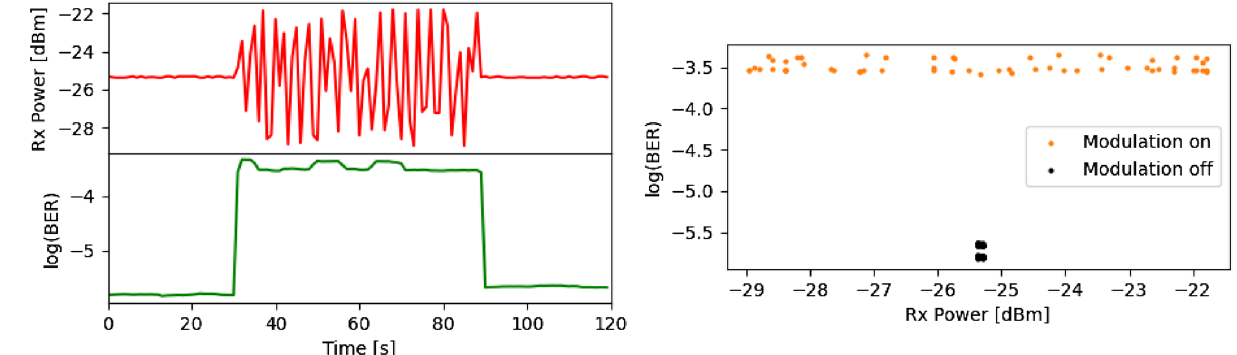
Figure 8. Left: time series for power (red) and log(BER) (green) for rapid power modulation test of DCO module. Right: scatter plot of BER versus power for modulation on (orange) and off